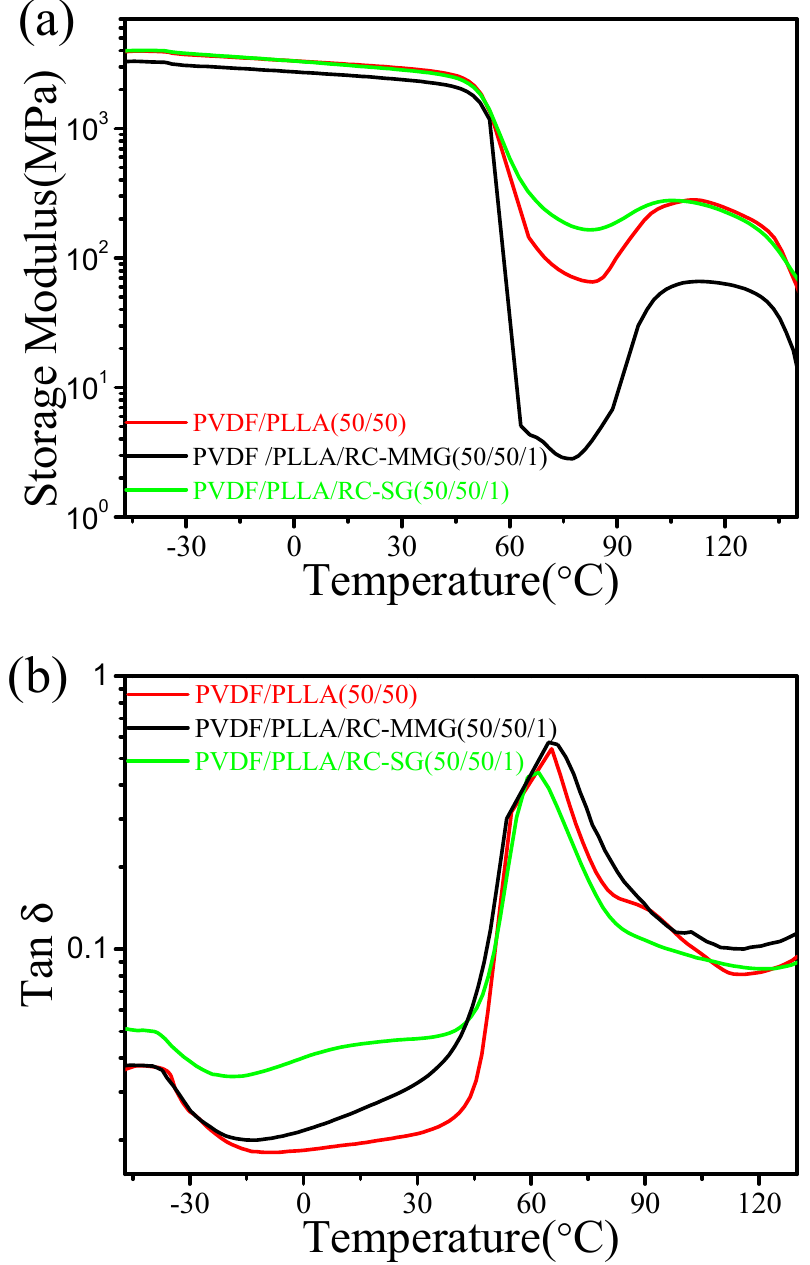
Figure 6. ( a ) Storage modulus and ( b ) loss tangent (tan delta) as a function of temperature with a frequency of 5 Hz for PVDF/PLLA (50/50, w/w) blend and compatibilized blends.